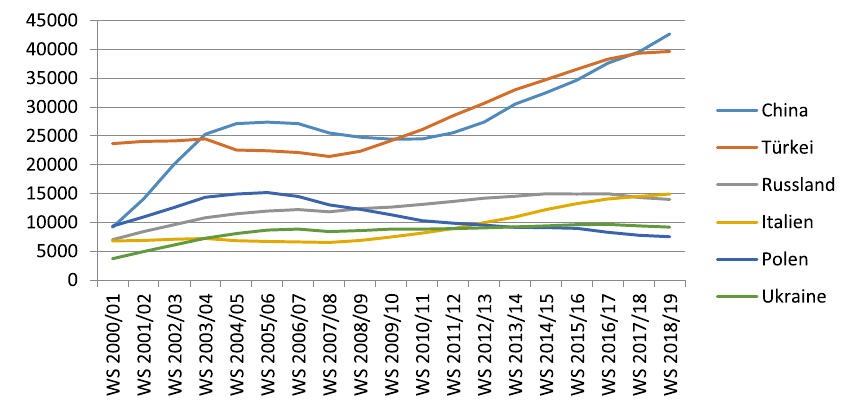
Fig. 1 Number of foreign students in Germany (DAAD